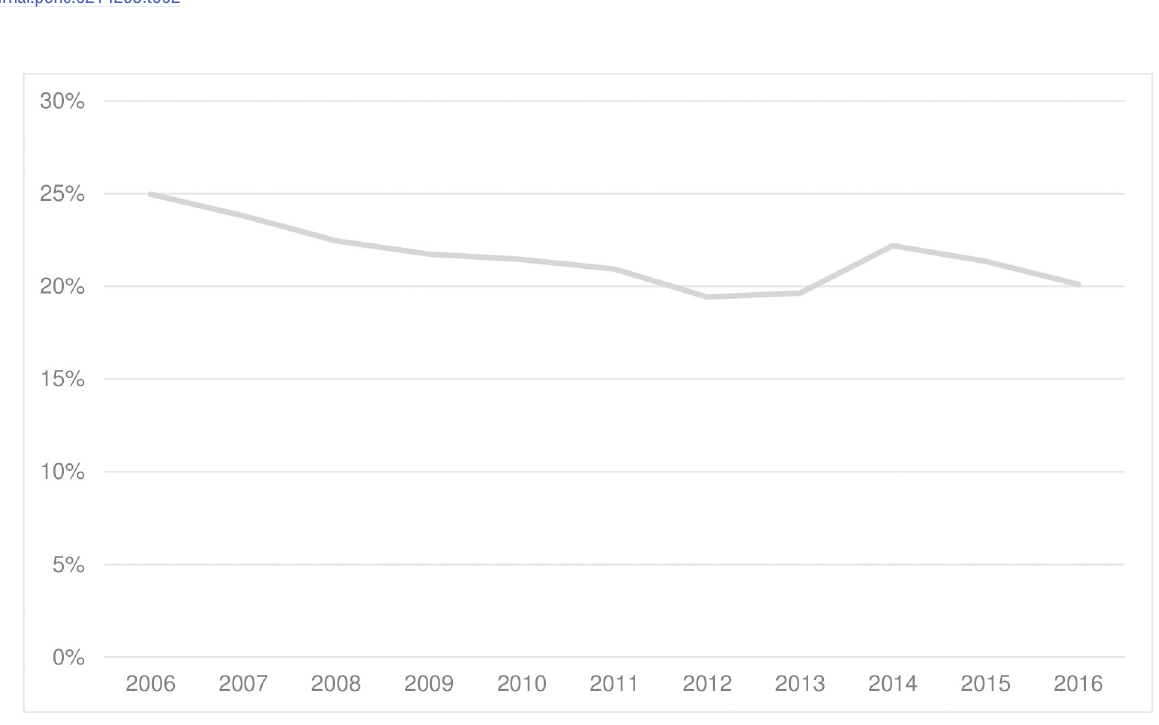
Fig 2. Maternal GBS colonisation.